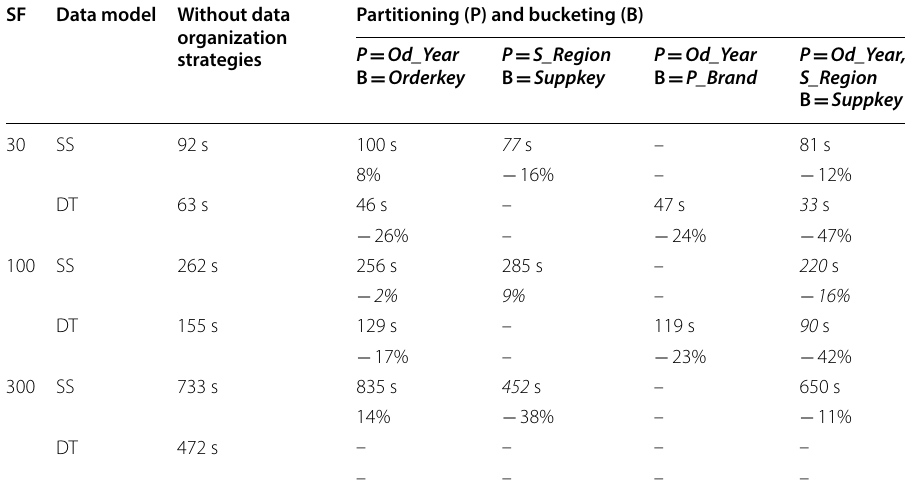
Italic values indicate the fastest processing time by SF, data model and configuration